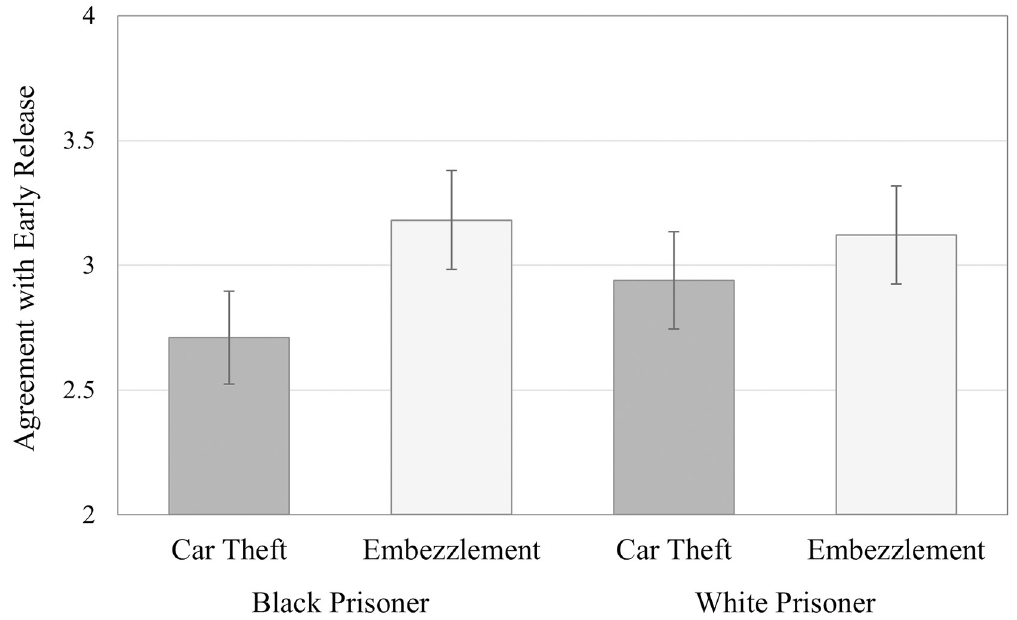
Fig 1. Bias in agreement with early release. Means (and standard errors) in levels of agreement with early release from prison due to COVID-19 pandemic, in function of the prisoner’s skin colour and of the type of crime committed.